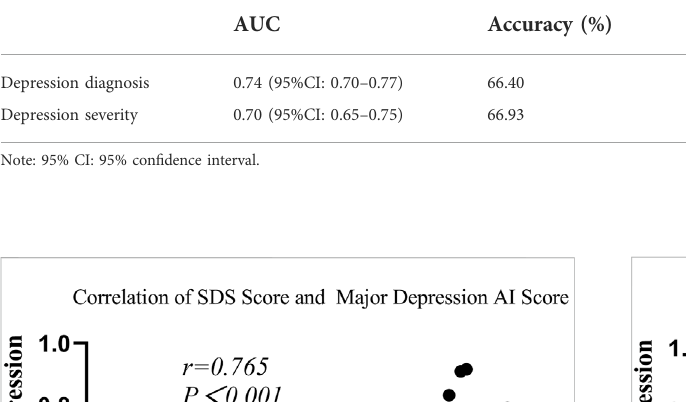
TABLE 3 Performance of the CNN model in depression diagnosis and its severity.